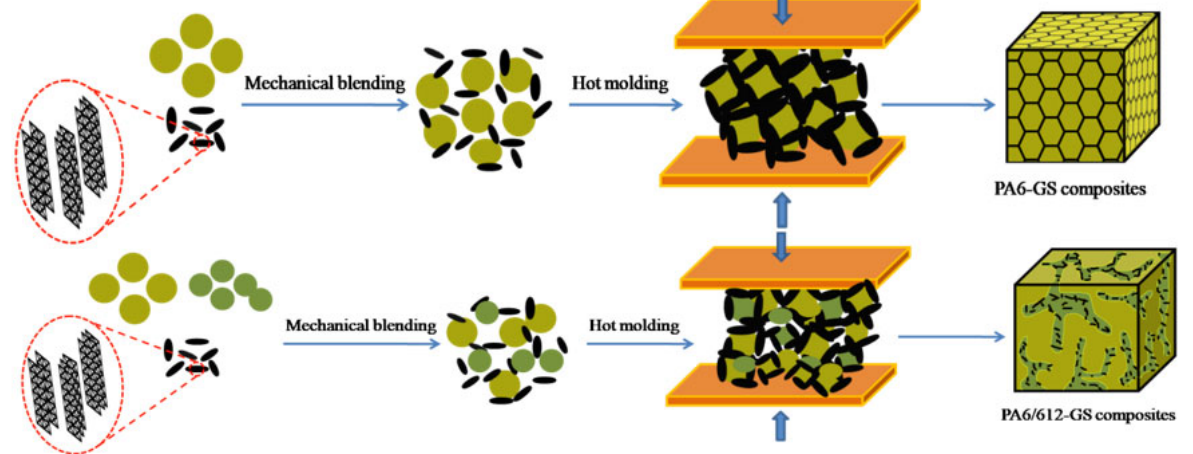
Figure 1. Schematic of the fabrication of the segregated PA6 -GS composite and PA6/612-GS composite under high pressure.